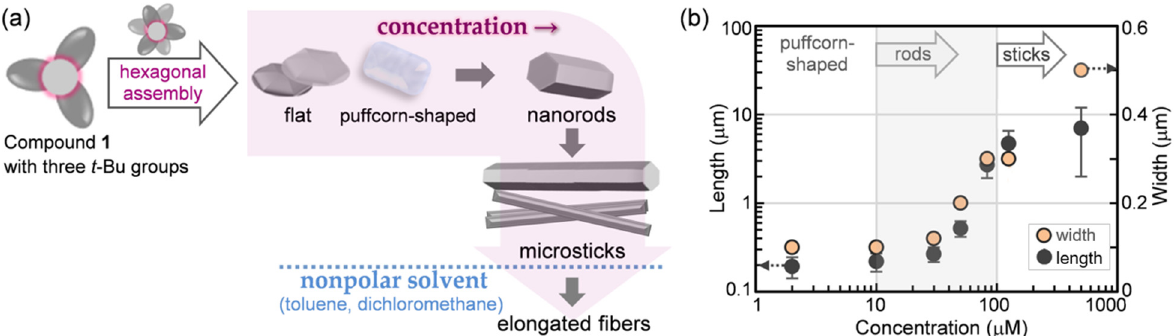
Figure 2. ( a ) Schematic representation of morphological transformation of compound 1 from flat structures and nanorods to microsticks and elongated fibers, depending on the concentration. ( b ) Dimensions of hexagonal structures produced in THF-H 2 O mixtures with different concentrations. The dimensions were calculated from SEM images (see also Figures 3 and S3).